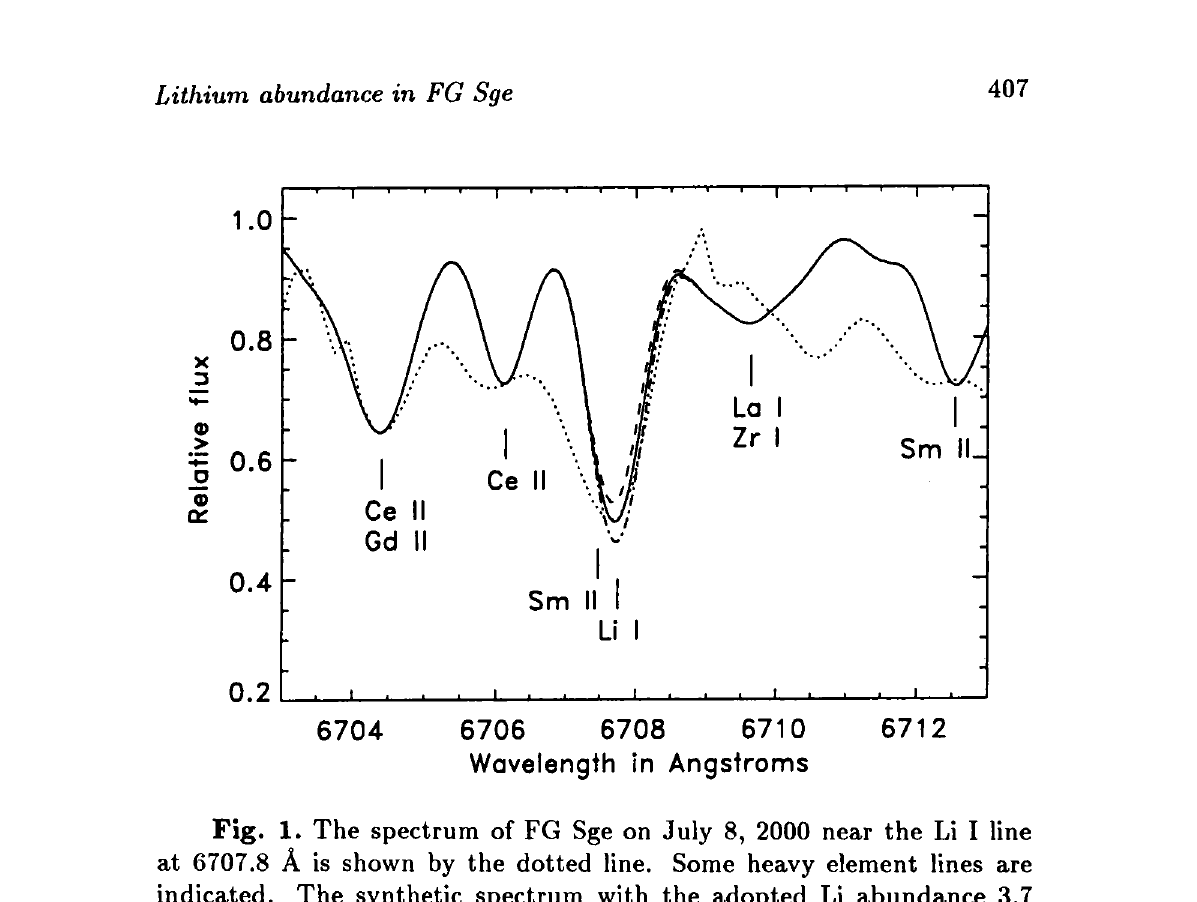
Fig. 1. The spectrum of FG Sge on July 8, 2000 near the Li I line at 6707.8 A is shown by the dotted line. Some heavy element lines are